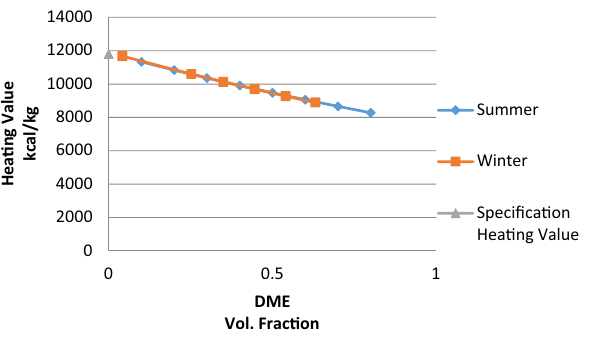
Fig. 19 Effect of adding DME on LPG propane content